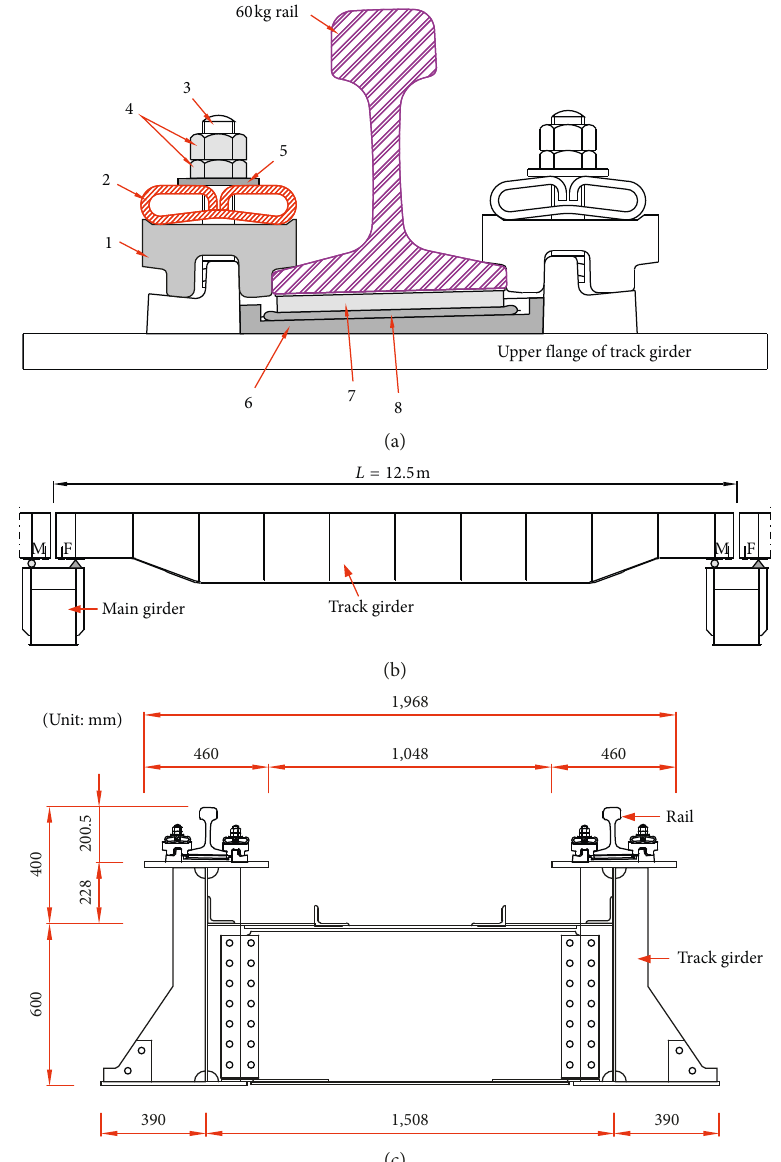
Figure 1: Schematics of the direct fixation track system. (a) Direct fixation rail fastening system: (1) insulation block; (2) leaf spring; (3) bolt; (4) antiloosening nut; (5) washer; (6) insulation plate; (7) rail pad; (8) adjustable pad. (b) Side view of the track girder. (c) Cross section of the track girder